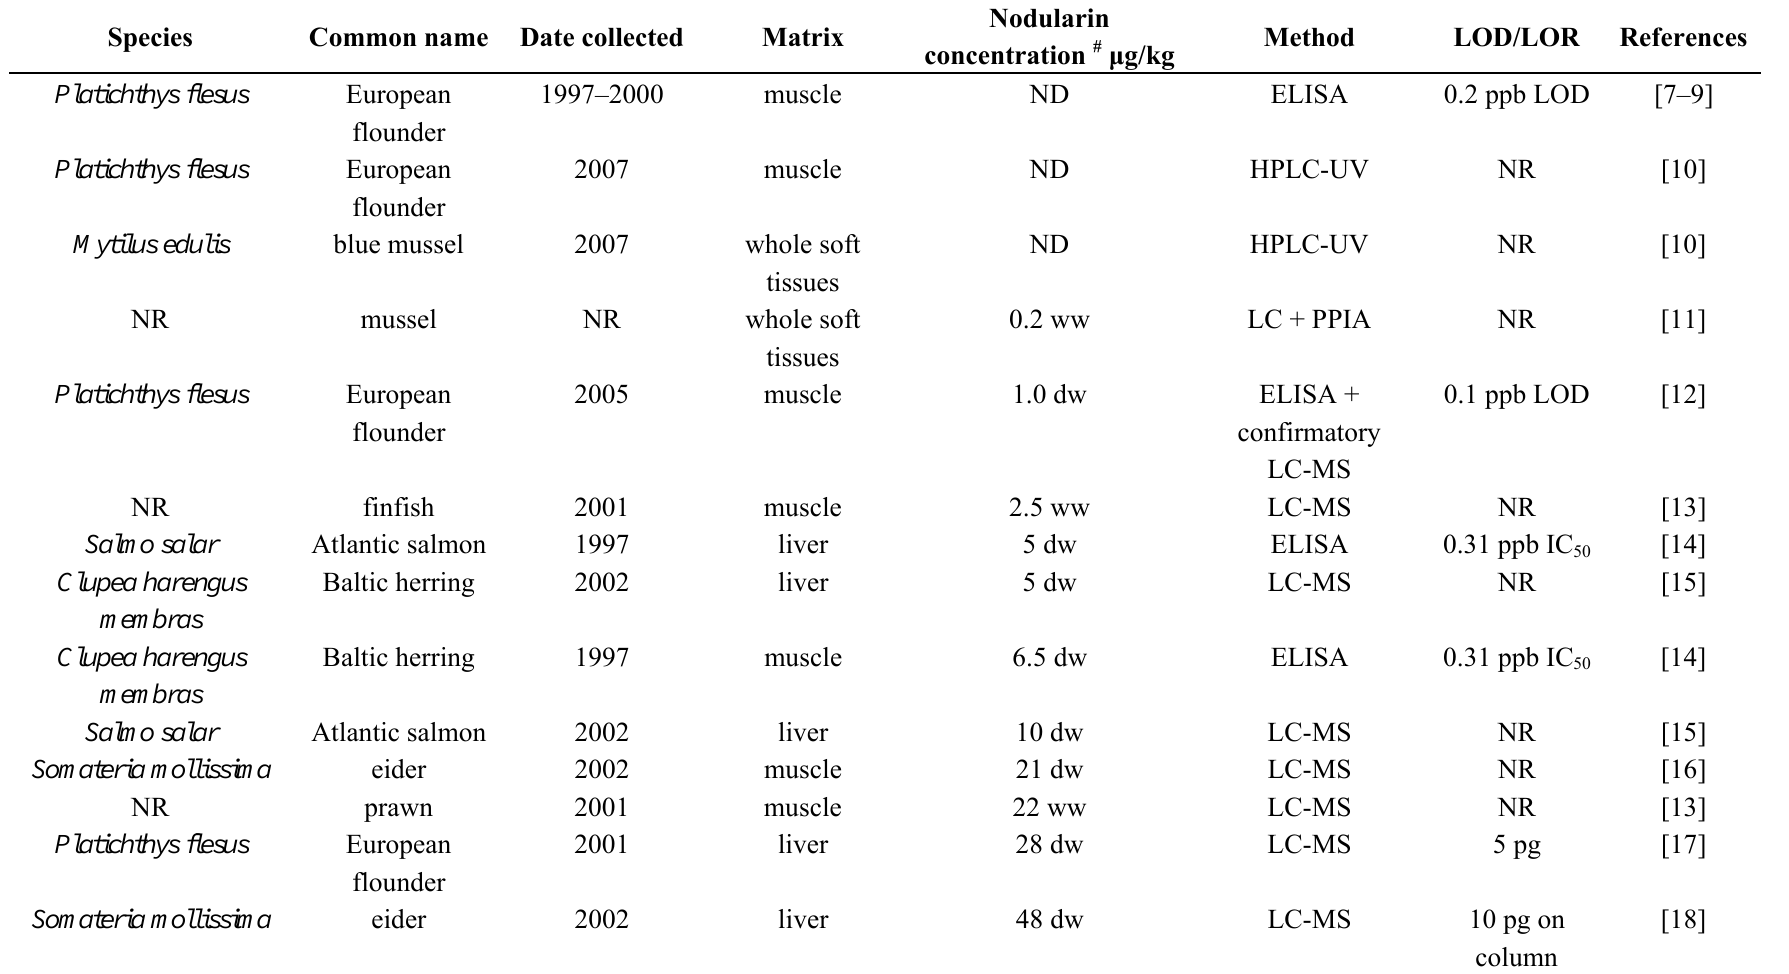
Table 1. Reported concentrations of nodularin in marine animal food